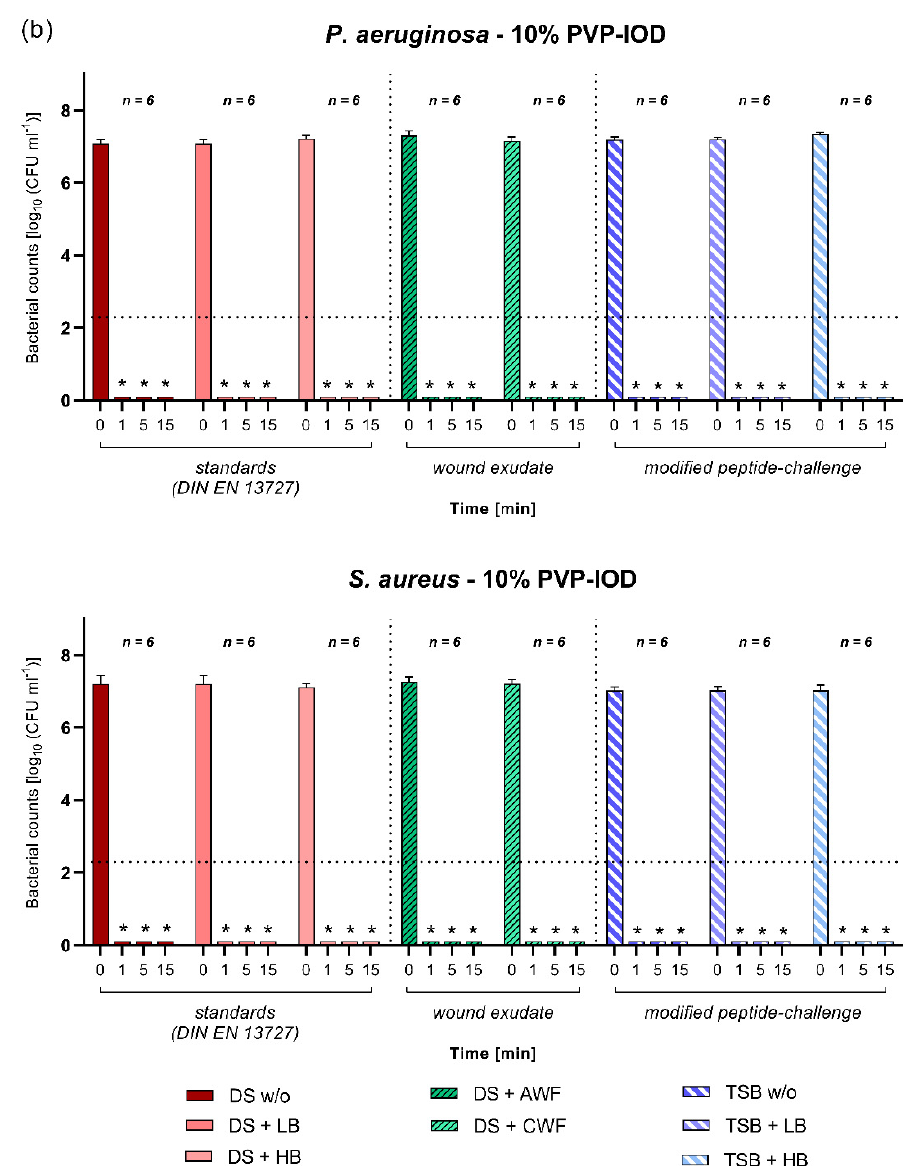
Figure 5. ( a , b ) Antimicrobial efficacy of ( a ) 0.1% octenidine/2% phenoxyethanol (OCT/PE) and ( b ) 10% povidone-iodine (PVP-IOD) antiseptics against P. aeruginosa and S. aureus . Bacterial survival rates (in log 10 CFU/mL) after 1, 5, and 15 min of exposure time under various challenge conditions and initial bacterial counts (0 min) are displayed. First section shows the standard DIN-EN-13727 conditions of no burden (DS w/o), low burden (DS + LB), and high burden (DS + HB) prepared in regular dilution solution (DS). Second section shows results when challenged with simulated wound conditions using human acute (DS + AWF) or chronic (DS + CWF) wound exudate in DS. Third section shows results for the modified-peptide challenge prepared in tryptone soy broth (TSB) with no burden (TSB w/o), low burden (TSB + LB), and high burden (TSB + HB). Values are expressed as mean ± SD (* p ≤ 0.05 vs. 0 min) and dotted line represents a reduction in 5 log 10 cfu/mL steps compared to initial bacterial counts.